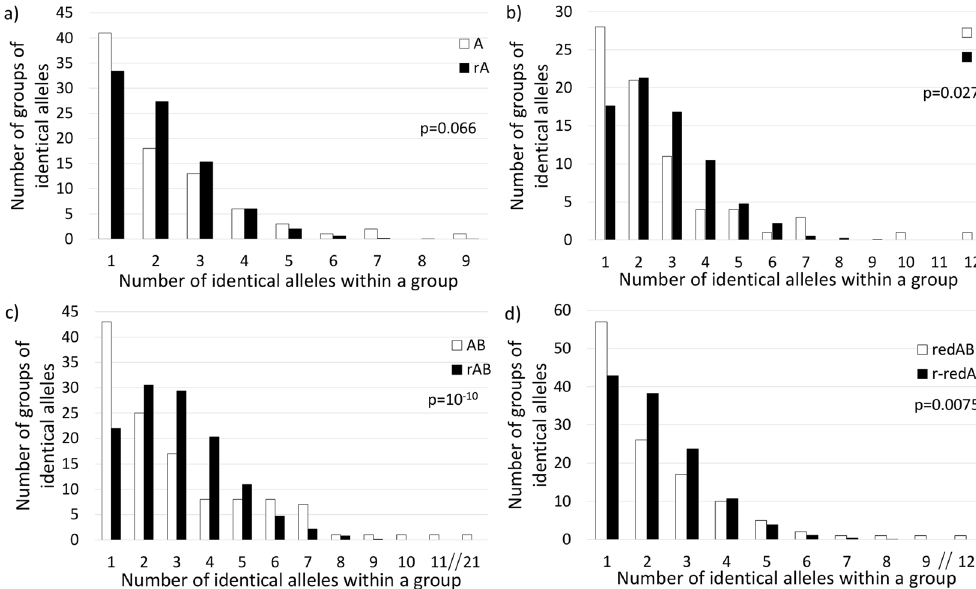
Figure 3. Frequency of csd alleles in the analysed populations. Histograms show the number of groups represented by a given number of identical alleles in Populations A ( a ), B ( b ) and AB ( c ) (white bars), which are compared to the distribution of alleles in the corresponding randomly generated datasets (rA, rB and rAB) (black bars). Histogram ( d ) shows the allele distribution in Population AB, which was calculated under the condition that any unique allele was counted only once if it was represented by several alleles identified in a single apiary (redAB), compared with the randomly generated dataset (r-redAB). The observed and random distributions were compared using the chi-test. The obtained p value is given in each